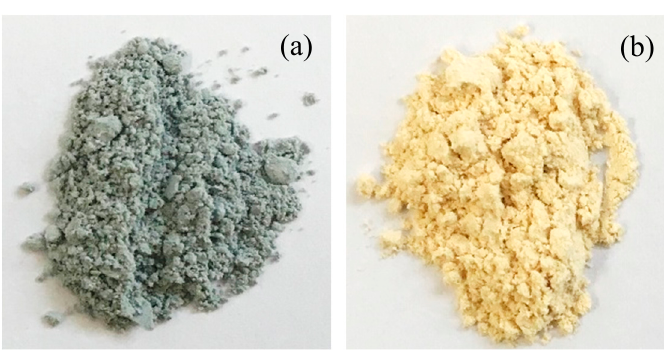
Figure 1. Photocatalysts Pd-P ( a ) and Pd-I ( b ).